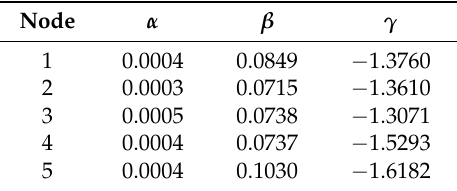
Table 2. The parameters of the five mobile energy storage clusters (MESCs) system using the optimal allocation method based on the consensus incremental cost.